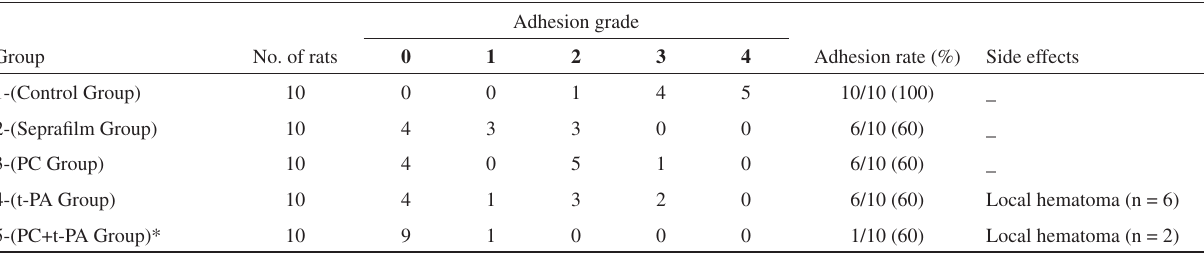
Group No. of rats